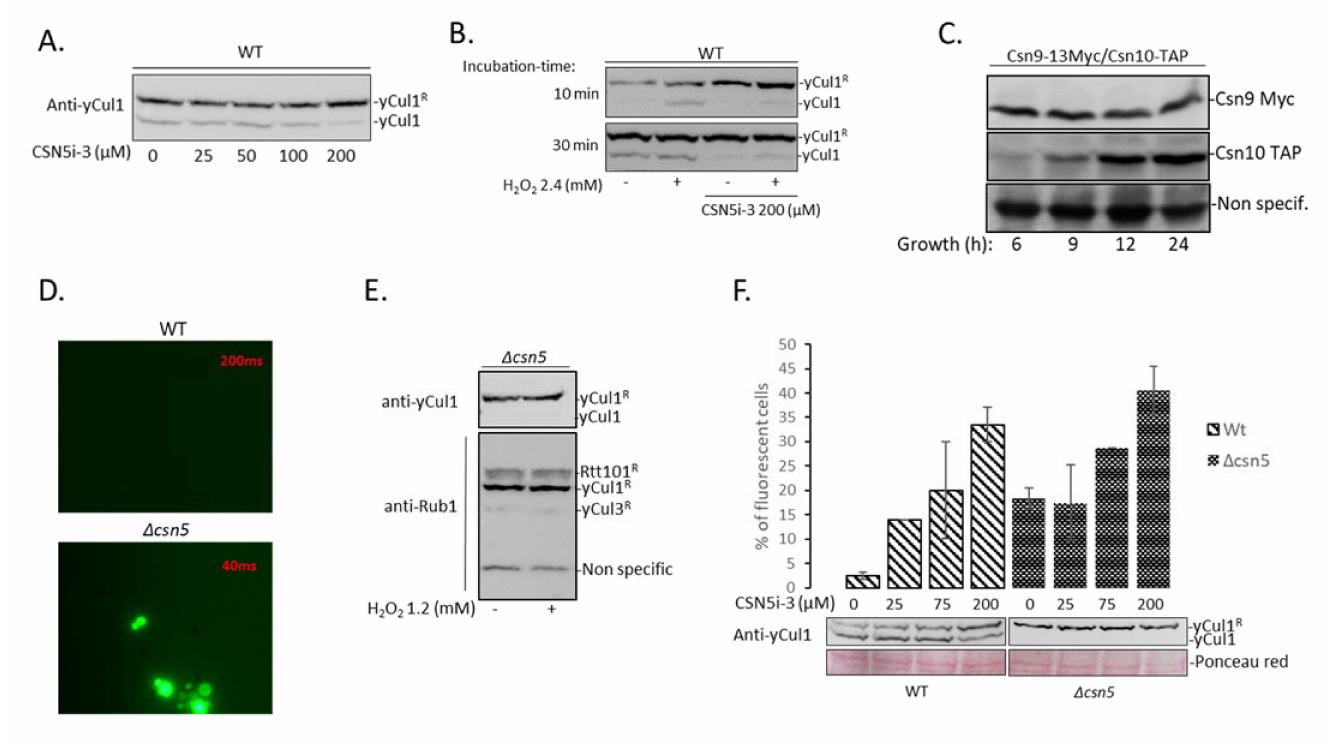
Figure 6. CSN activity in oxidized condition. ( A ) Logarithmic wildtype (WT) cells were treated with CSN5i-3 for 2 h as indicated and immunoblotted for yCul1. ( B ) Logarithmic wildtype cells were treated with 200 µ M of CSN5i-3 for 2 h before adding 2.4 mM H 2 O 2 for 10 or 30 min before immunoblotted for yCul1. ( C ) The expression of CSN subunits was evaluated overtime in a wildtype strain in which Csn9 is C-terminally tagged by 13Myc and Csn10 is C-terminally TAP tagged. Myc antibodies and rabbit IgG were used for immunoblotting. ( D ) Wildtype and ∆ csn5 cells were treated with DCFDA and fluorescence was viewed by microscope. Notably, the mutant fluorescence was much higher than wildtype; thus, images were taken in a lower intensity (40 ms). ( E ) Logarithmic ∆ csn5 mutant cells were treated with H 2 O 2 for at least 30 min and cullin neddylation status was assessed by immunoblotting with antibodies for yCul1 (top) or for Rub1 (bottom), recognizing the three yeast neddylated cullins (yCul1, Rtt101, and yCul3). ( F ) Endogenous ROS levels of wildtype and ∆ csn5 cells with and without the inhibitor (0, 25, 75, and 200 µ M) were observed following DCFDA treatment. Two random fields were selected for each sample during quantification. The average intensity was calculated based on the number of fluorescent cells in the fields. Immunoblots are shown for yCul1 neddylation status; ponceau red is a loading